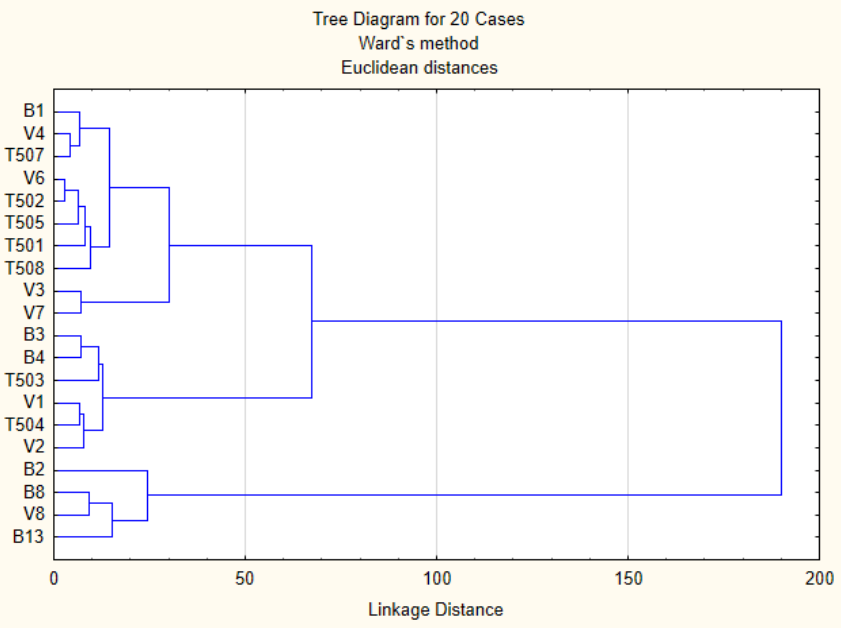
Figure 3. Cluster dendrogram of walnuts chemical composition.